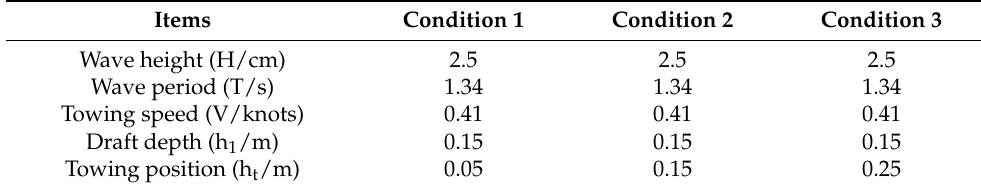
Figure 16. Comparison of test and simulation of towing force.